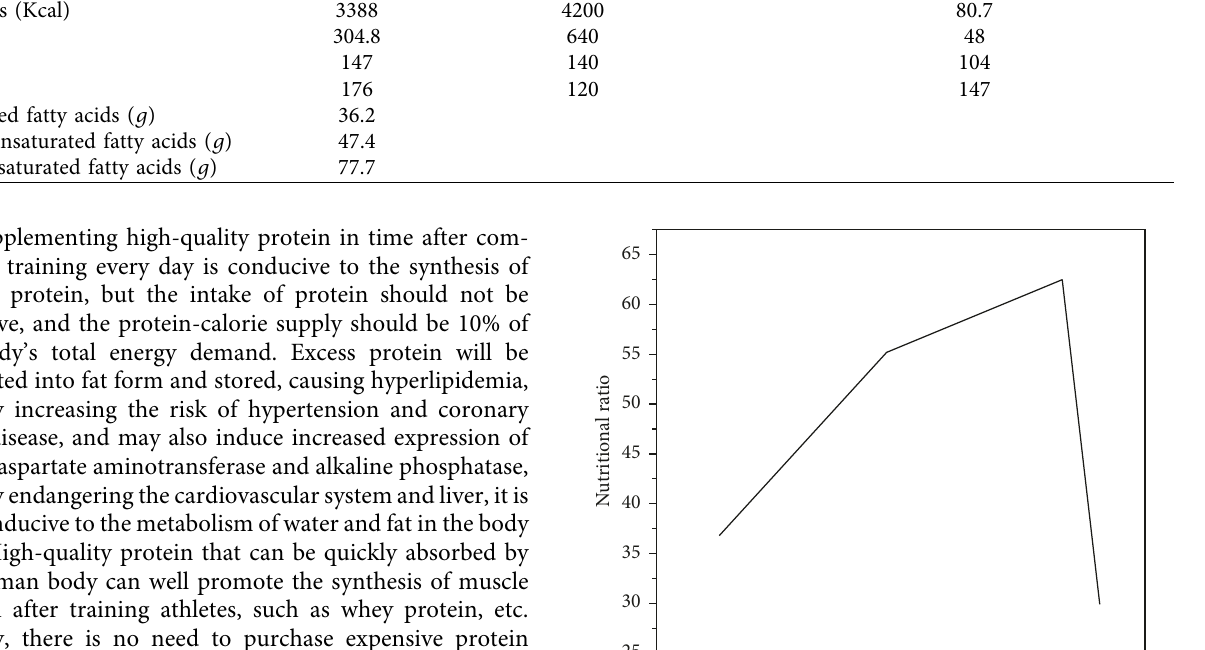
Table 4: The comparison of the daily intake of the three major nutrients per person and the recommended supply.